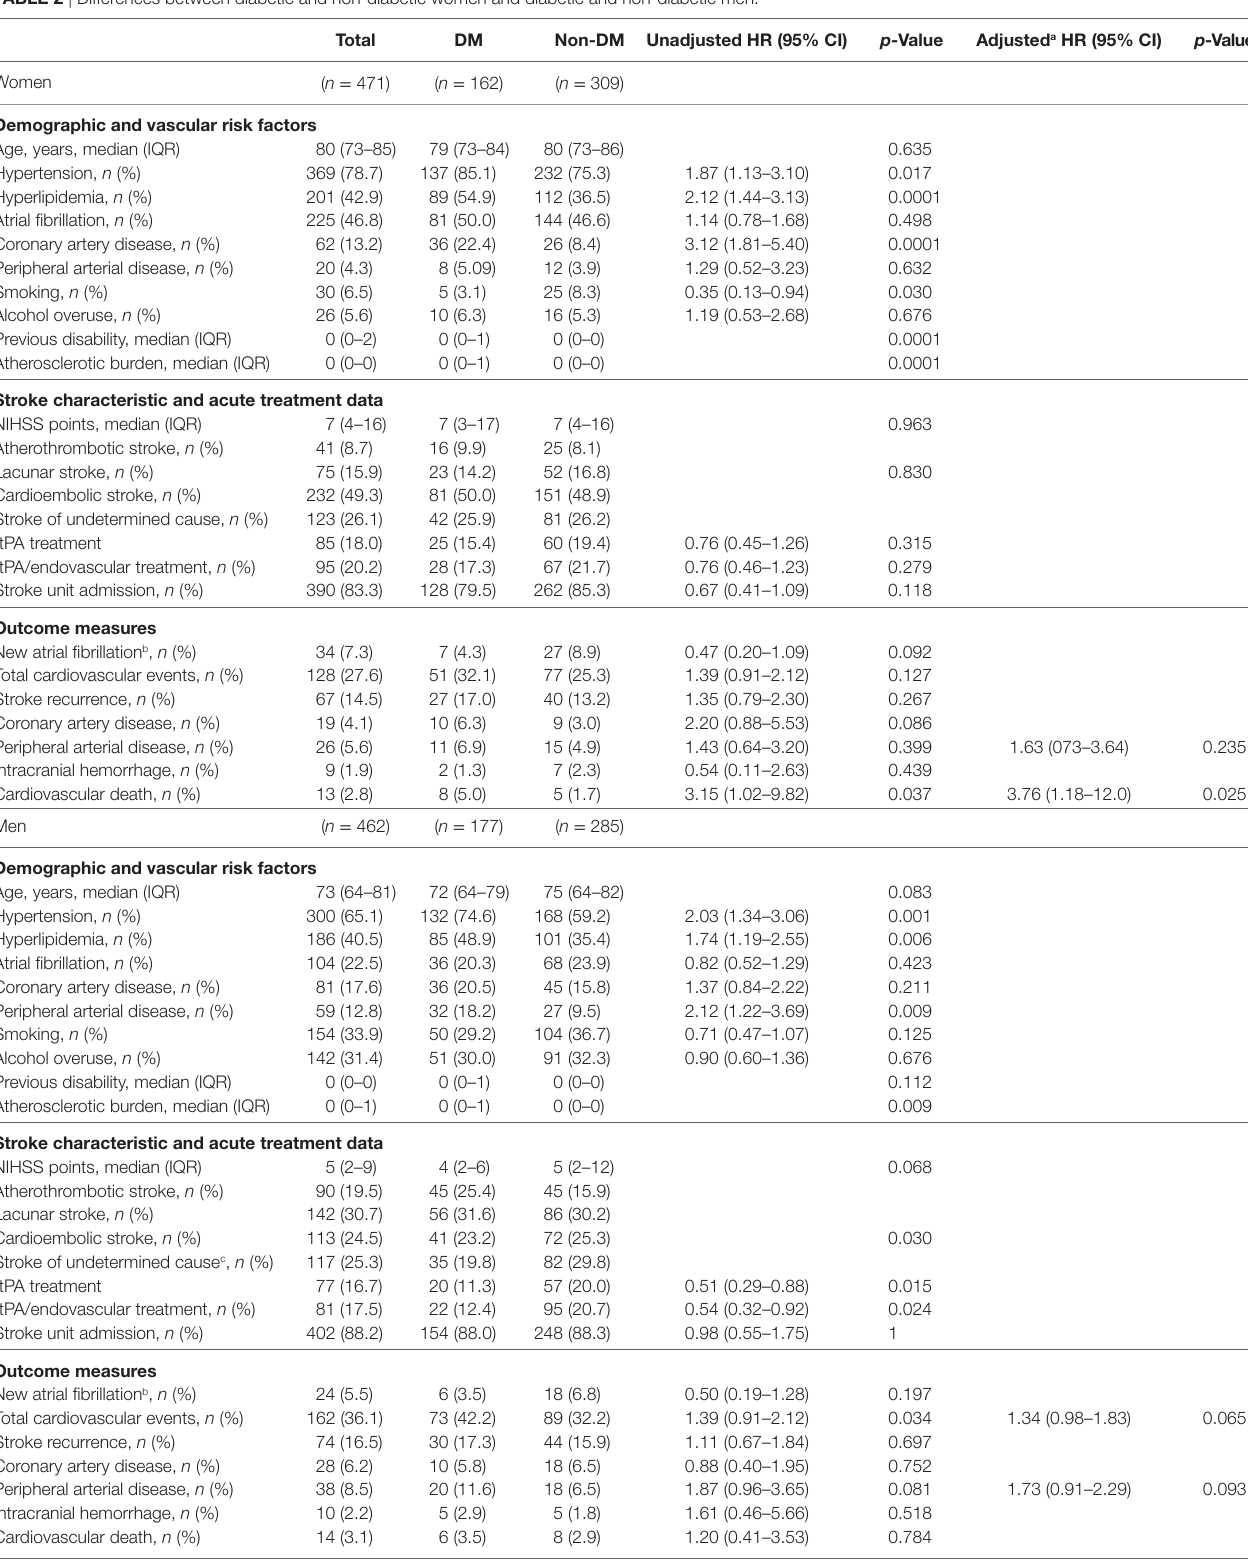
TaBle 2 | Differences between diabetic and non-diabetic women and diabetic and non-diabetic